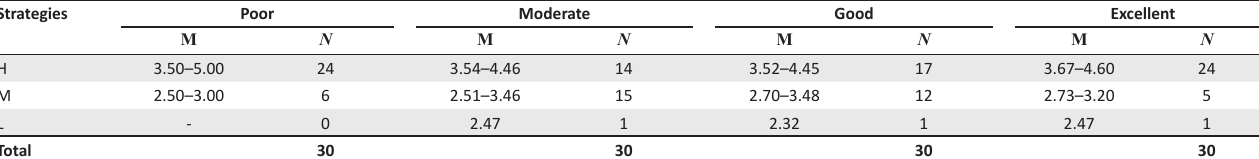
TABLE 5: Strategy use by proficiency. Strategies